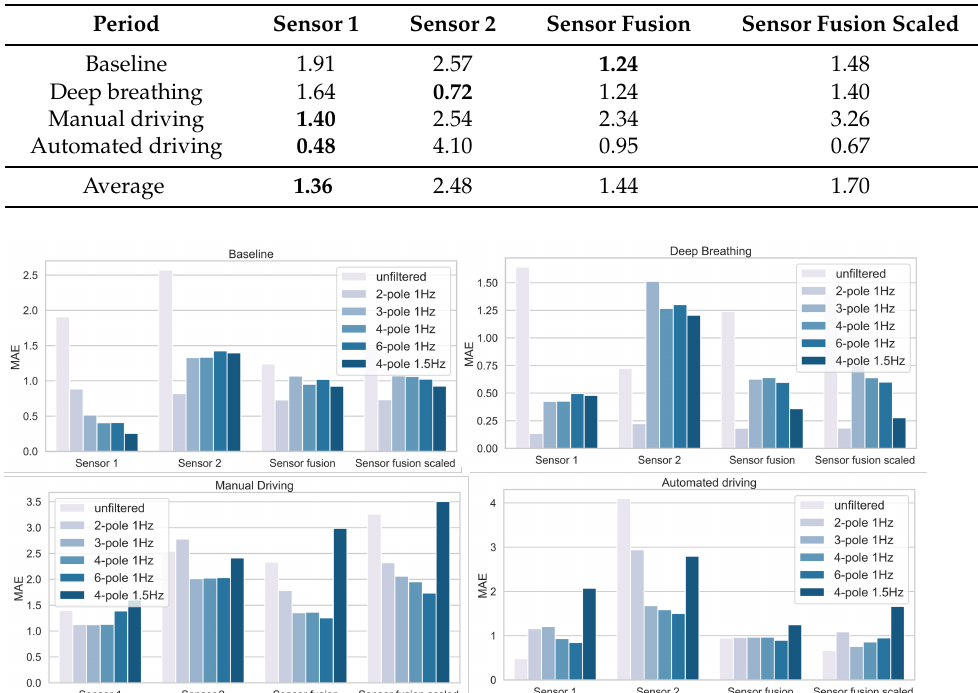
Figure 7. Effect of filter type and sensor on the mean absolute error of participants’ respiratory rate (in min − 1 ), from data collected in the third test session. Filters varied in the number of poles and cut-off